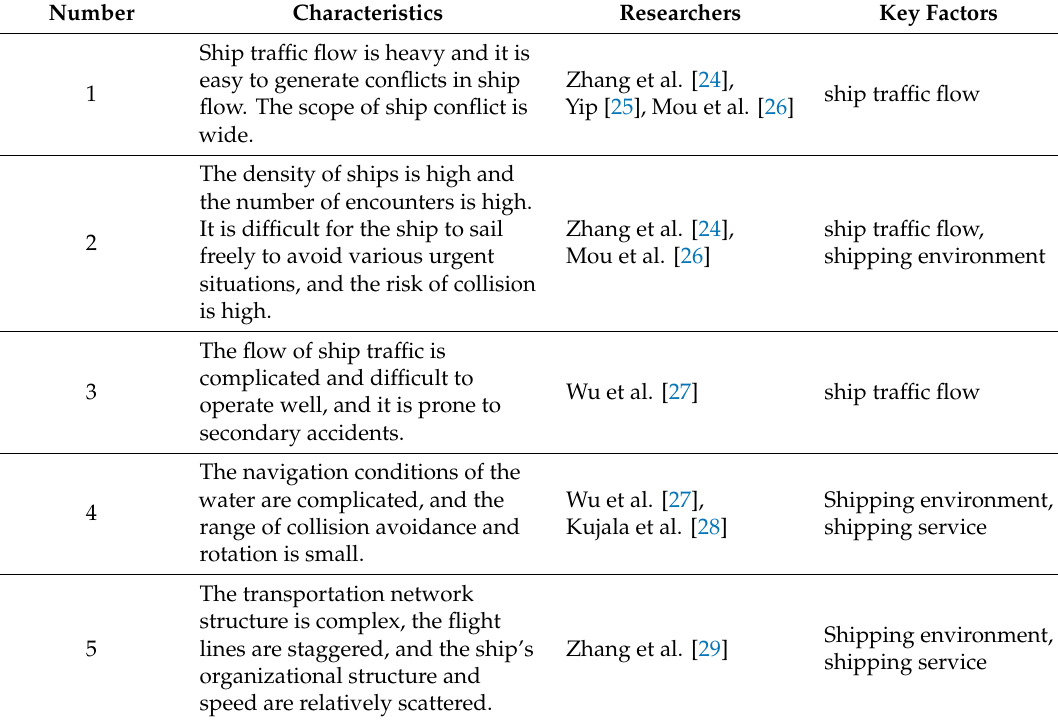
Table 1. Characteristics of tra ffi c-intensive areas of the water transportation